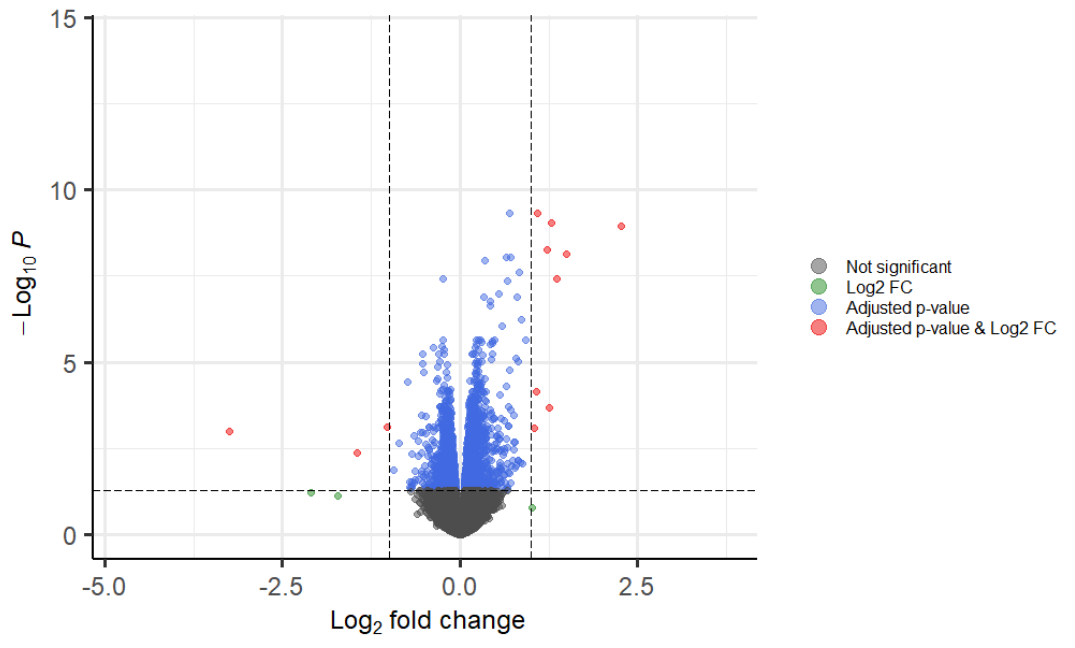
Figure 6. Volcano plot from RNA sequencing analysis. Genes with significant modulation are visualized with a volcano plot, to show statistical significance (adjusted p -values) versus magnitude of change (fold-change). Genes in red have a corrected p -value less than 0.05 and a log fold-change greater than 1. Table 1. Enrichment ratio within gene clustering.